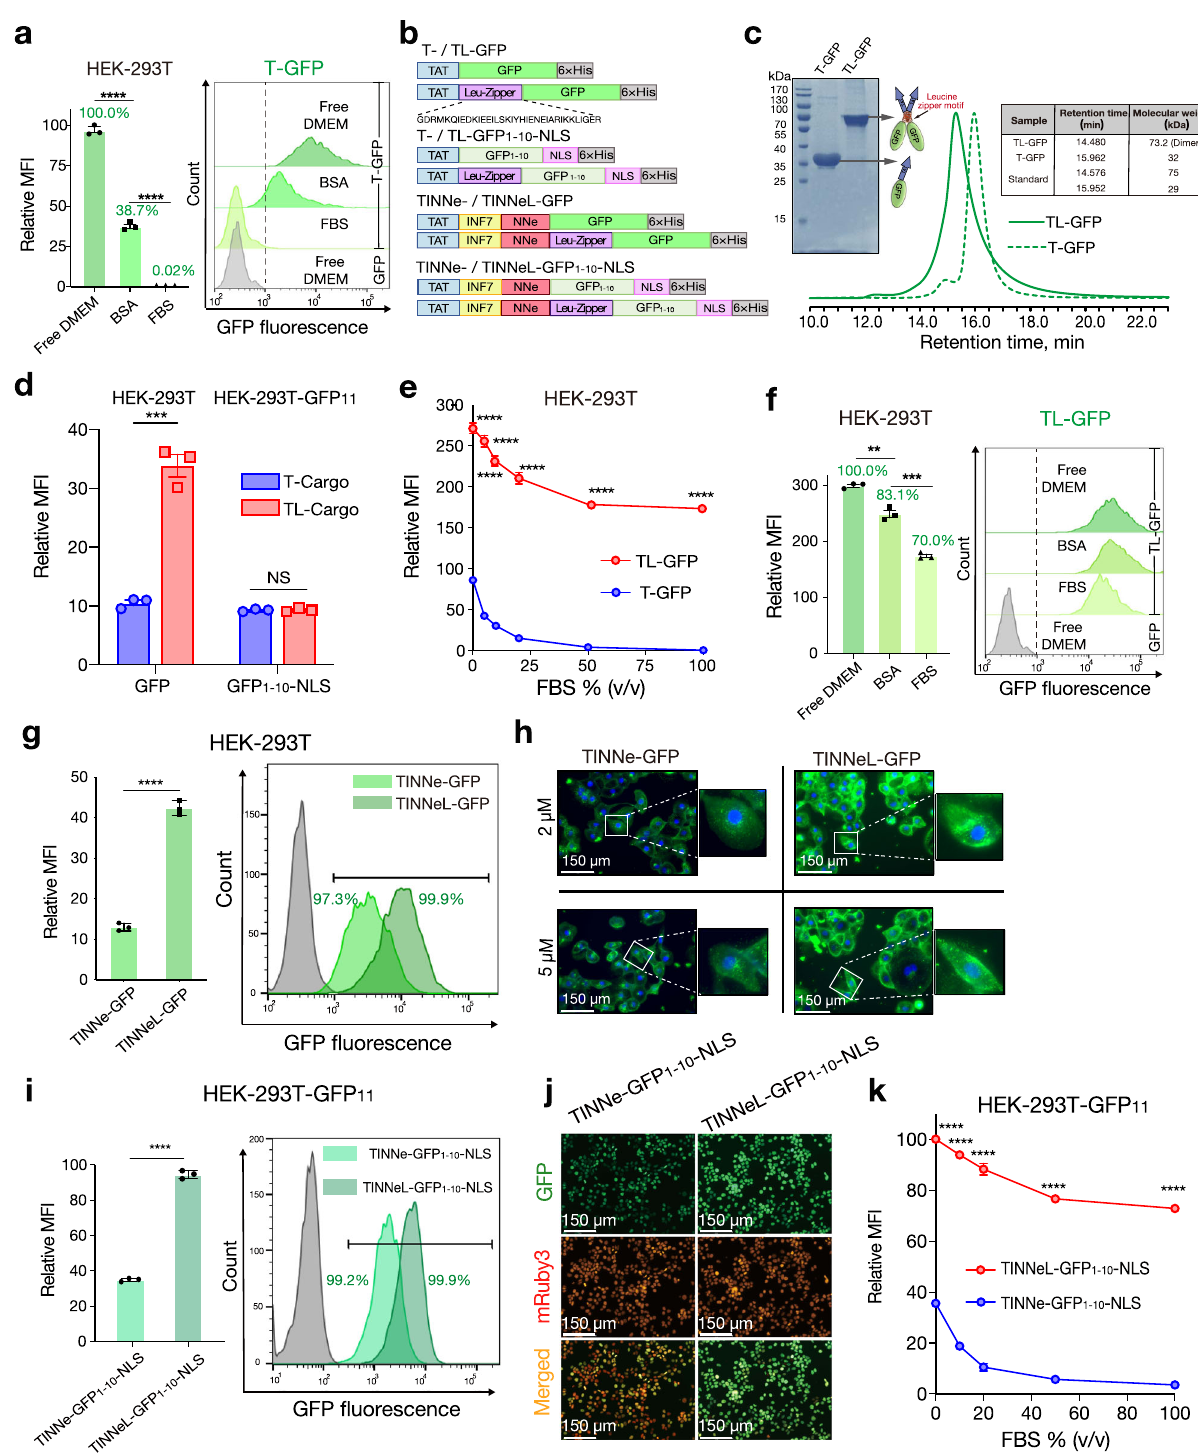
these results show that the four-module chimaeric peptide TINNeL, which is named the enhanced TAT-based intracellular delivery system (eTAT), has the capacity to deliver cargos into the cytosol ef fi ciently even in the presence of 100% serum. eTAT-Ppm1b suppresses TNF-induced necroptosis in vitro and in vivo . Necroptosis can be induced by tumour necrosis factor- α (TNF- α ), and the phosphorylation